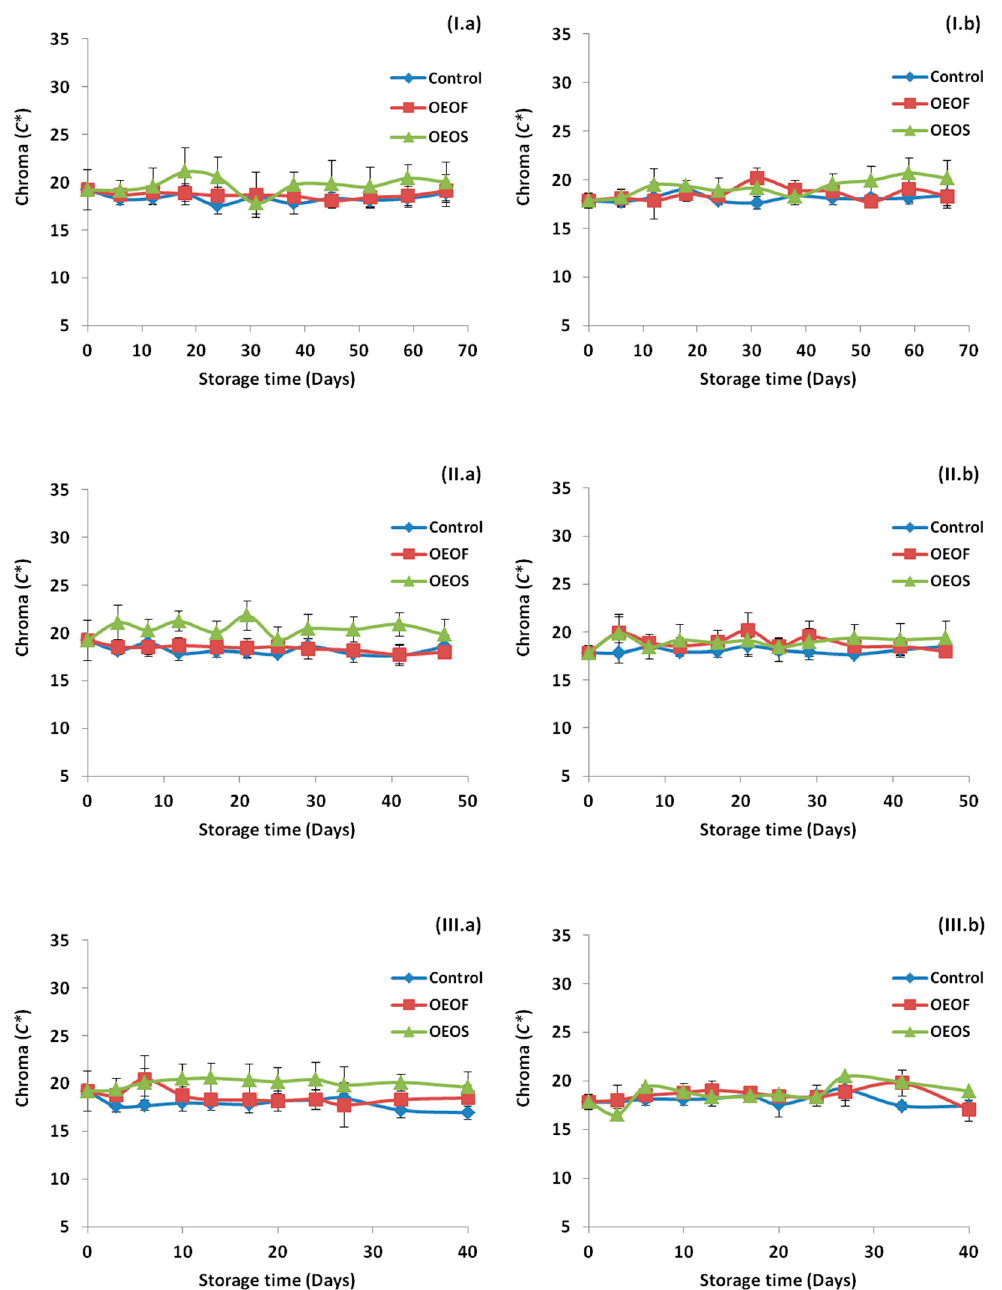
Figure 6. Changes in C * values for ham slices without ( a ) and after ( b ) high pressure processing treatment, during storage at 4 °C ( I ), 8 °C ( II ) and 12 °C ( III ). Values regarding control and OEOF samples (without essential oil), are common with those reported in our previous study